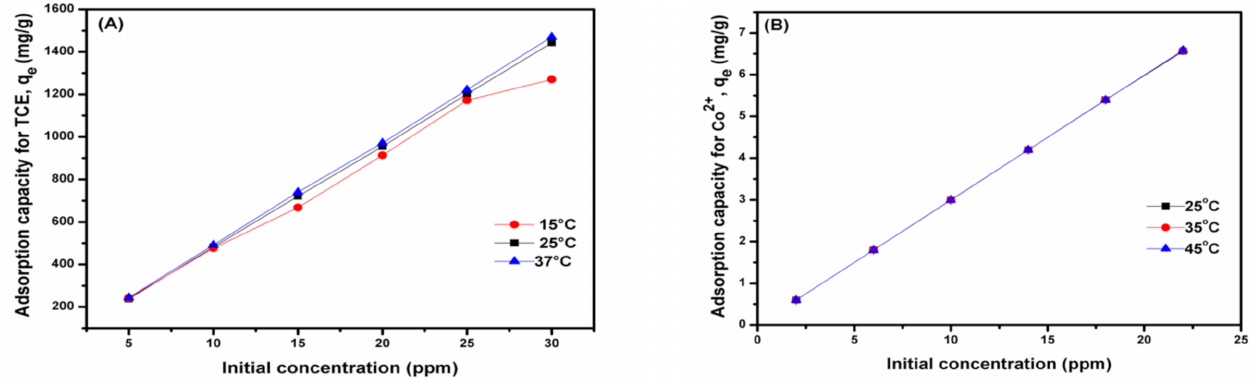
Figure 2. Effect of initial concentration at different temperatures on the adsorption of TCE ( A ) and Co 2+ ( B ). Conditions: m (adsorbent dose) = 0.0005 g (for TCE) and 0.1 g (for Co 2+ ), time = 24 h, pH (TCE) = 2; pH (Co 2+ ) = 7.5, V = 30 mL, and speed = 200 rpm.